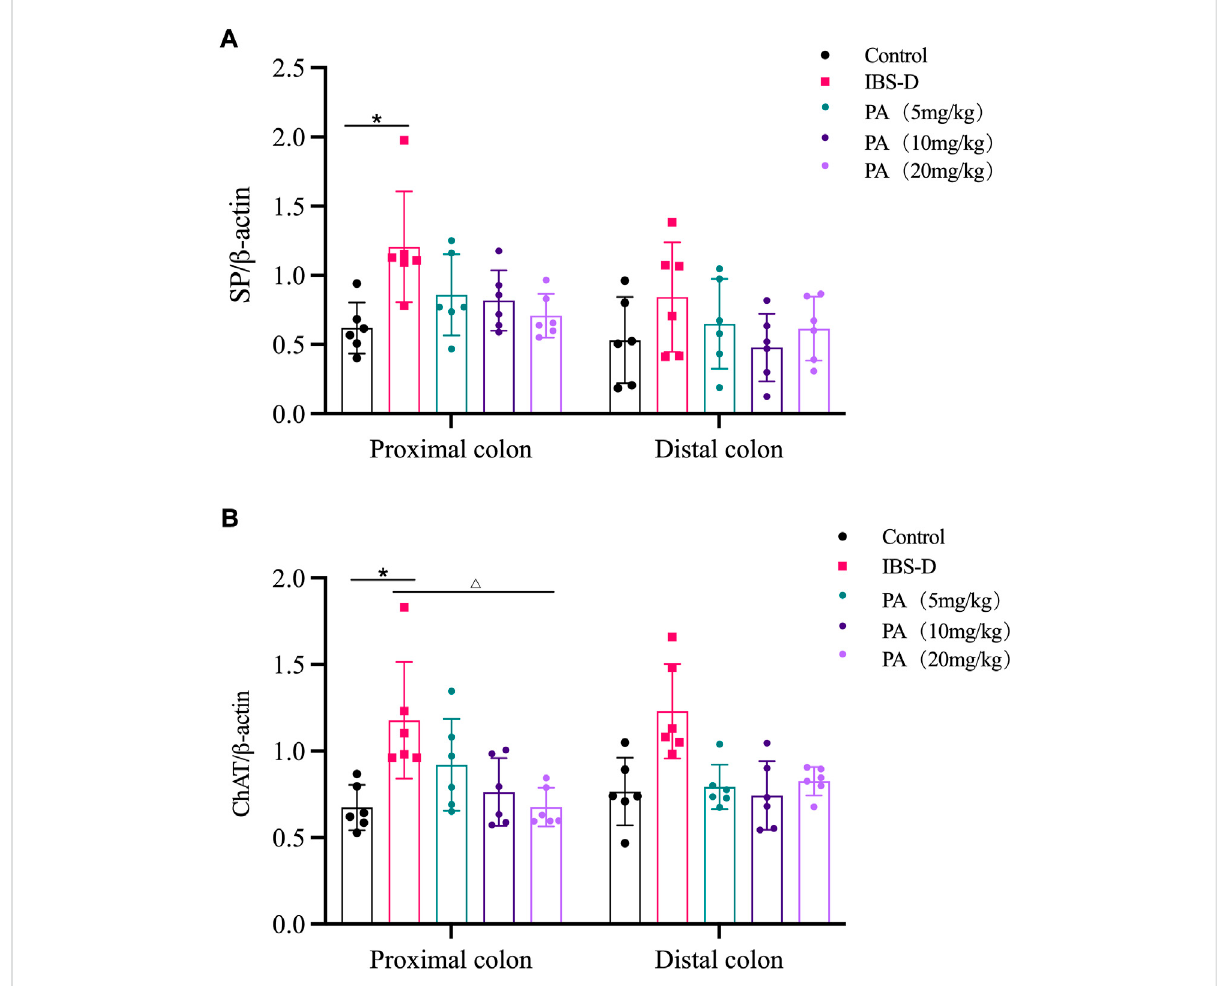
FIGURE 12 Effects of patchouli alcohol (PA) on substance P (SP) and choline acetyltransferase (ChAT) protein expression. SP and ChAT proteins were quanti fi edbywesternblot. β -actinwasusedasinternalreference. (A) SPproteininthedistalandproximalcolonofPAgroups. (B) ChATproteininthe distal and proximal colon of PA groups. Data are presented as mean ± SD ( n = 6). * p < 0.05, vs. controls. △ p < 0.05, vs.